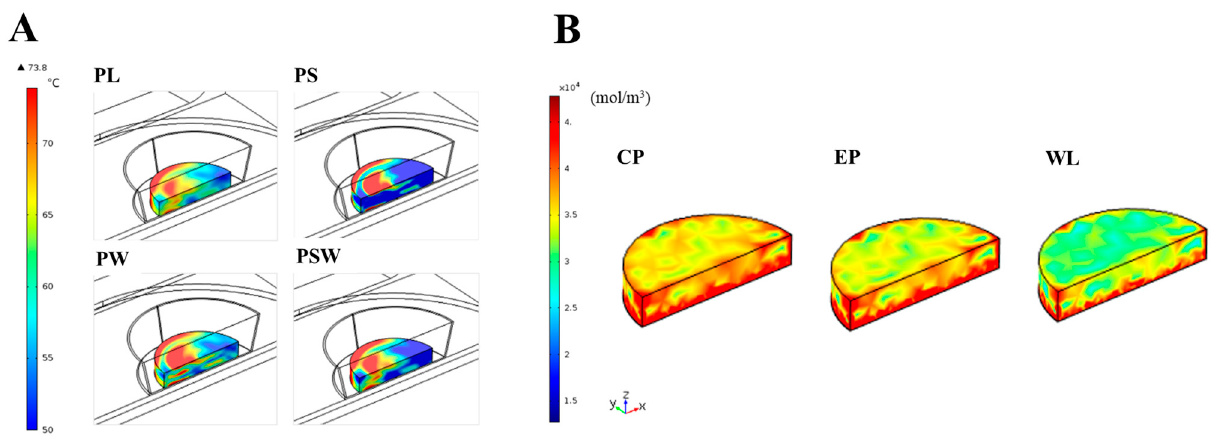
Figure 10. Simulated temperature distributions for the pork patties with different compositions ( A ) and moisture content distribution of PSW patty heated in the various containers ( B